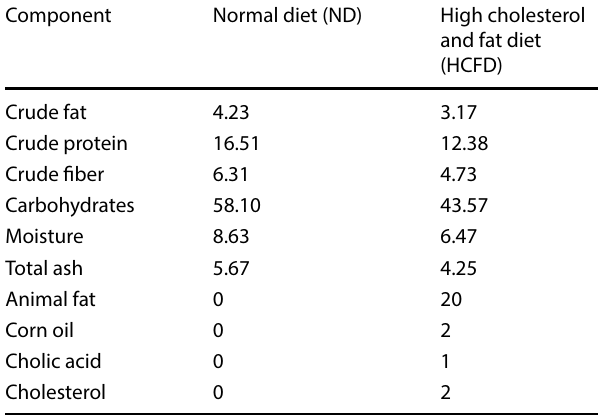
Table 1 Composition of diets used (g/100 g of diet) Component Normal diet